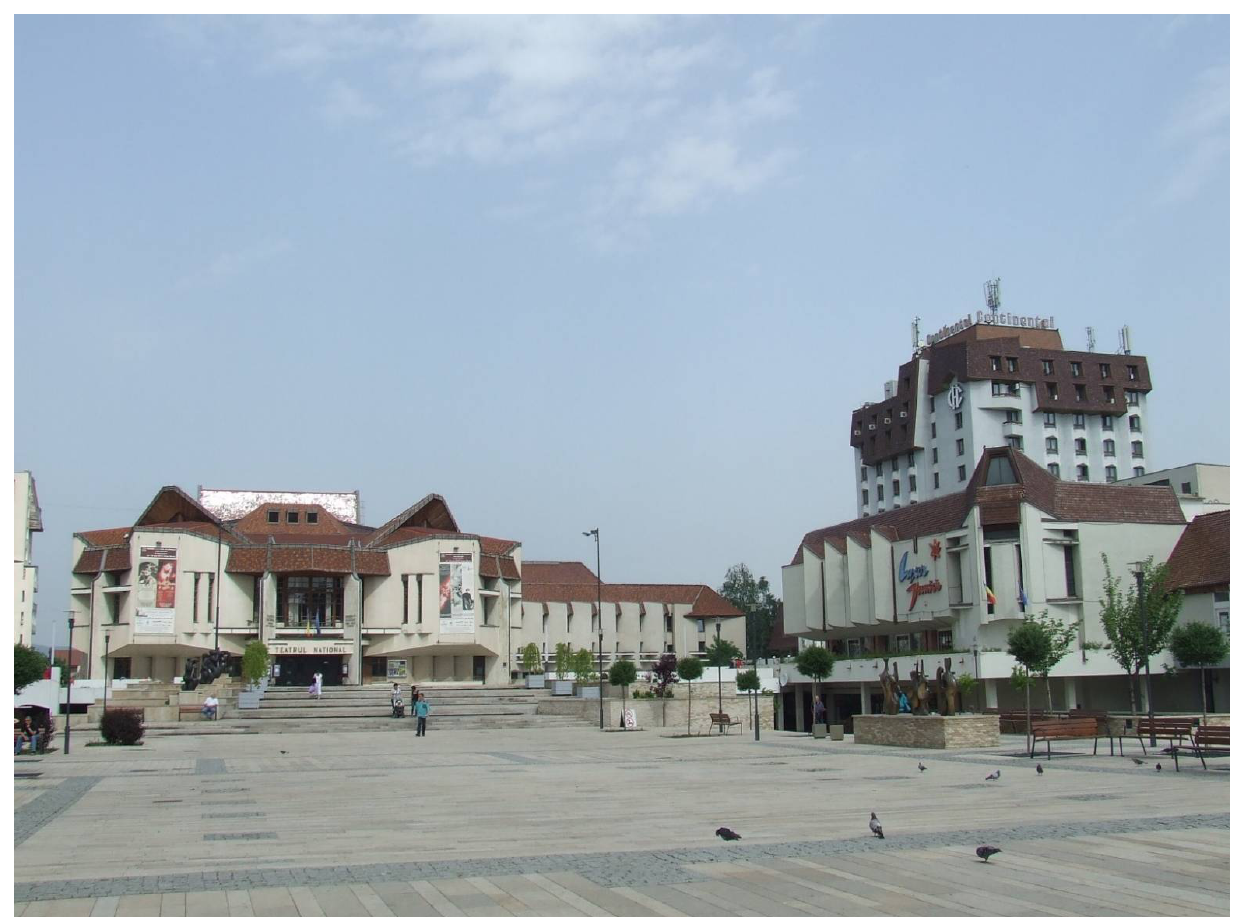
Figure 5. The Theater and Square that Replaced Târgu Mureș’s Franciscan Catholic Church. The socialist government represented the move to demolish—that is, transform into waste—the Franciscan church and its contents as part of its post-World War II plan to create “the new socialist man,” even as it also utilized the project as part of ongoing international relations campaigns. Many late socialist regimes embraced the belief that socialism’s new man needed a new built environment along with a new economic, cultural, and social system. As a result, throughout the Eastern Bloc architectural space became funda- mental to the individual and social transformation that was envisioned, replacing the ped- agogical processes that had originally stood at its heart (Fehérváry 2013; Sammartino 2017). This “ideology in infrastructure” produced significant amounts of waste when the